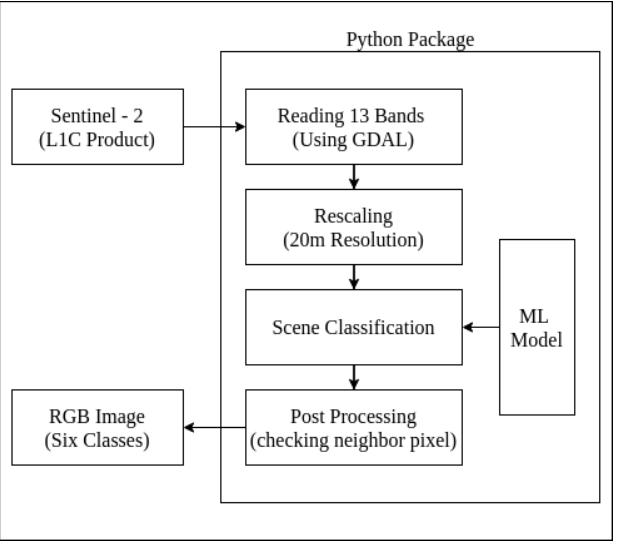
Figure A1. Package Processing Steps: Classifying Sentinel-2 L1C Product.